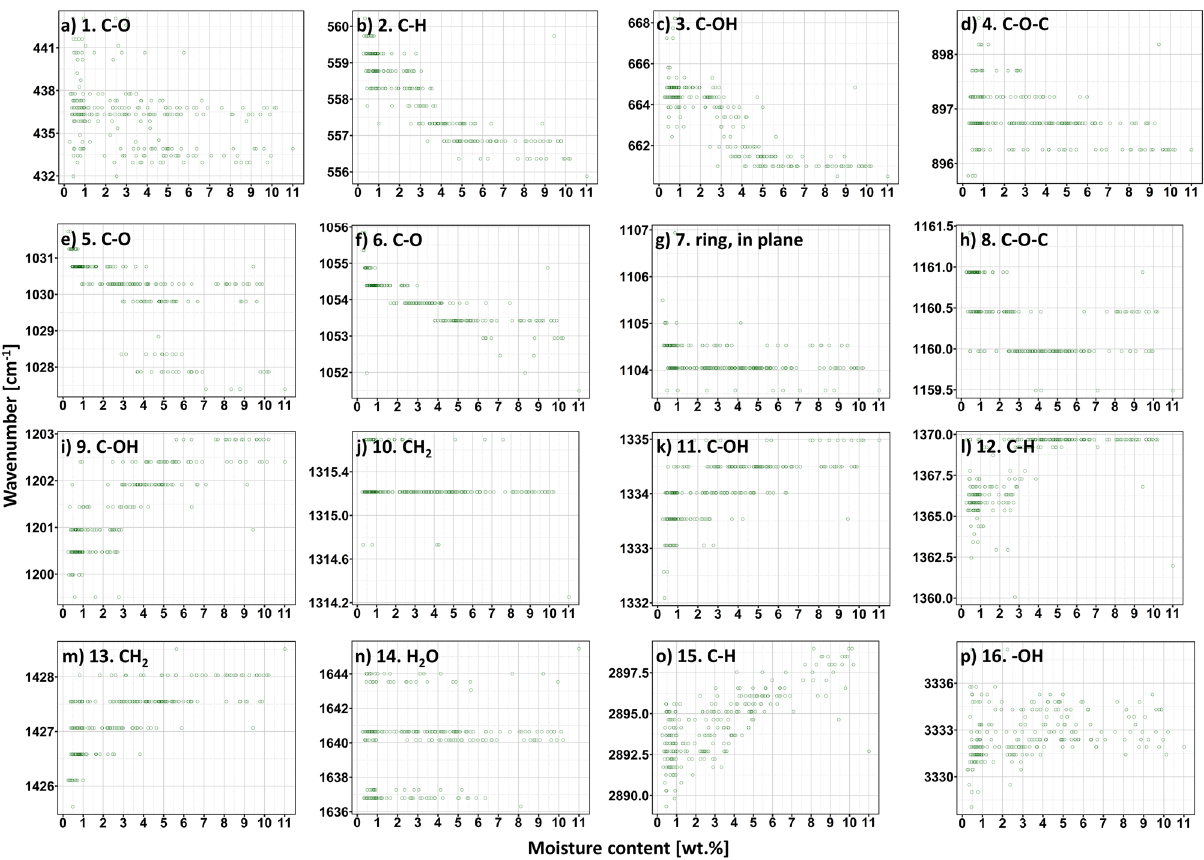
Figure 4. Wavenumber of the selected peaks ( a–p ) plotted as a function of moisture content in cellulose fibres determined by the means of Karl-Fischer titration. No linear regressions were